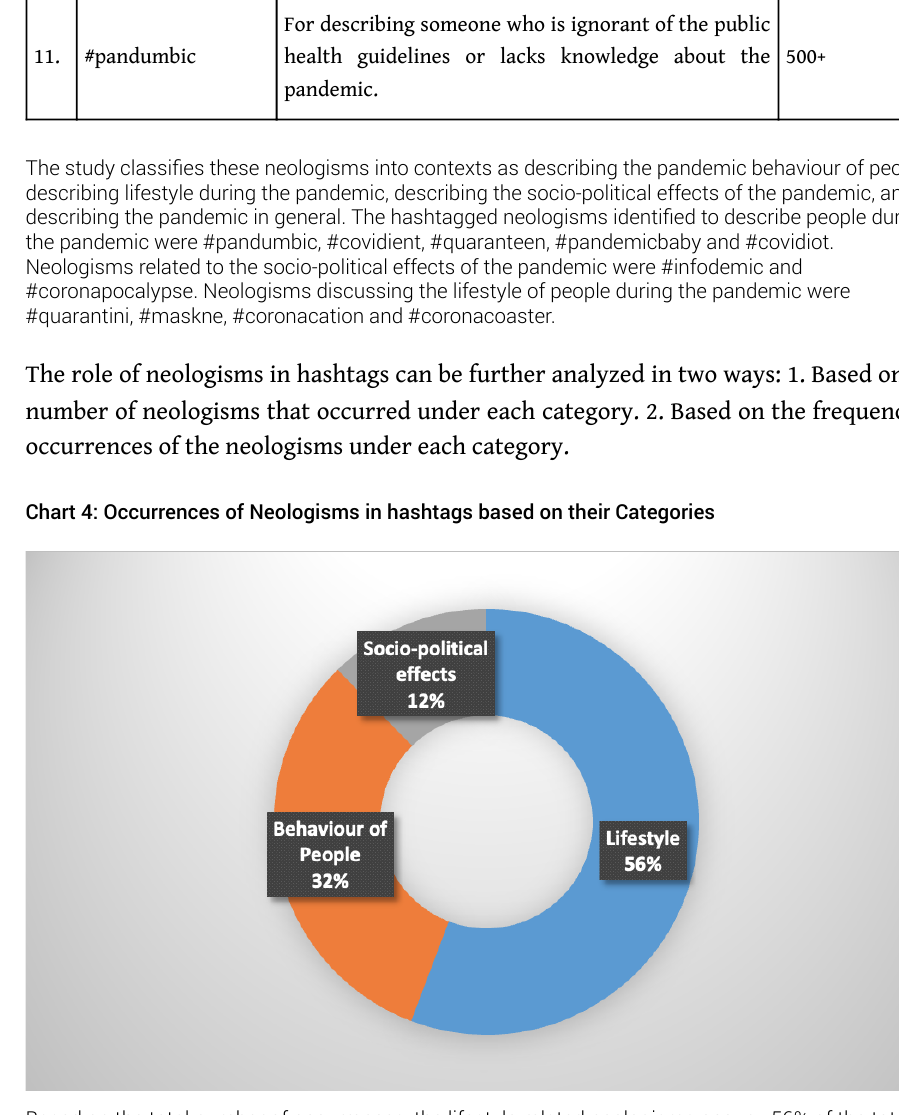
Based on the total number of occurrences, the lifestyle-related neologisms occupy 56% of the total occurrences, neologisms for describing people in the pandemic, 32%, and neologisms related to